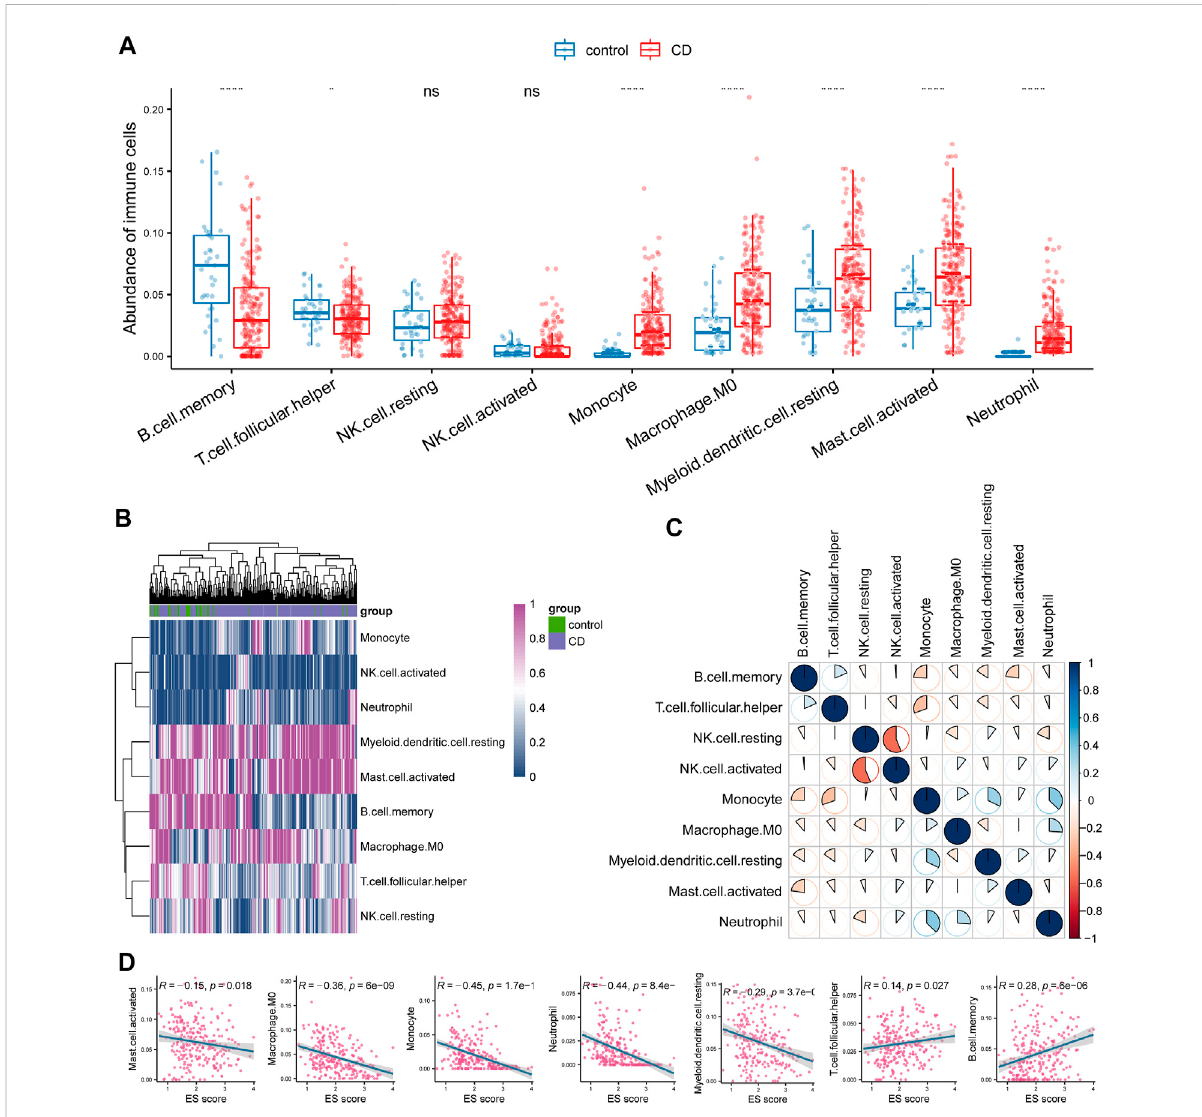
FIGURE 3 Investigation of immune microenvironment of CD. (A) Comparison of the abundance of immune cells between control and CD tissues. (B) Heatmapanalysisalsoindicatedadistinctexpressionofthesecellsbetweenthegroups. (C) Correlationanalysisbetweendifferentimmunecelltypes in CD. (D) Enrichment score (ES) of circadian rhythm was negatively correlated with monocyte, M0 macrophage, myeloid dendritic cell, activated mast cell, and neutrophil whereas positively correlated with B cell and T cell follicular